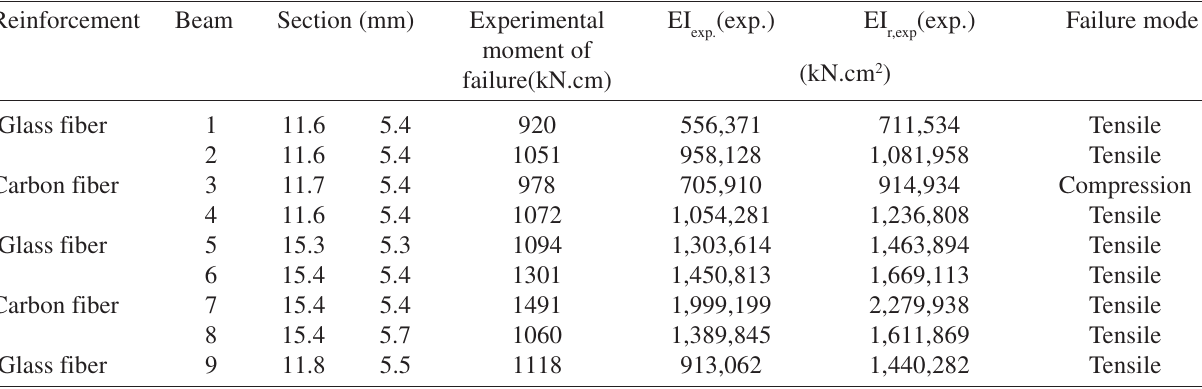
Table 3. Experimental values of moment of failure and bending stiffness.